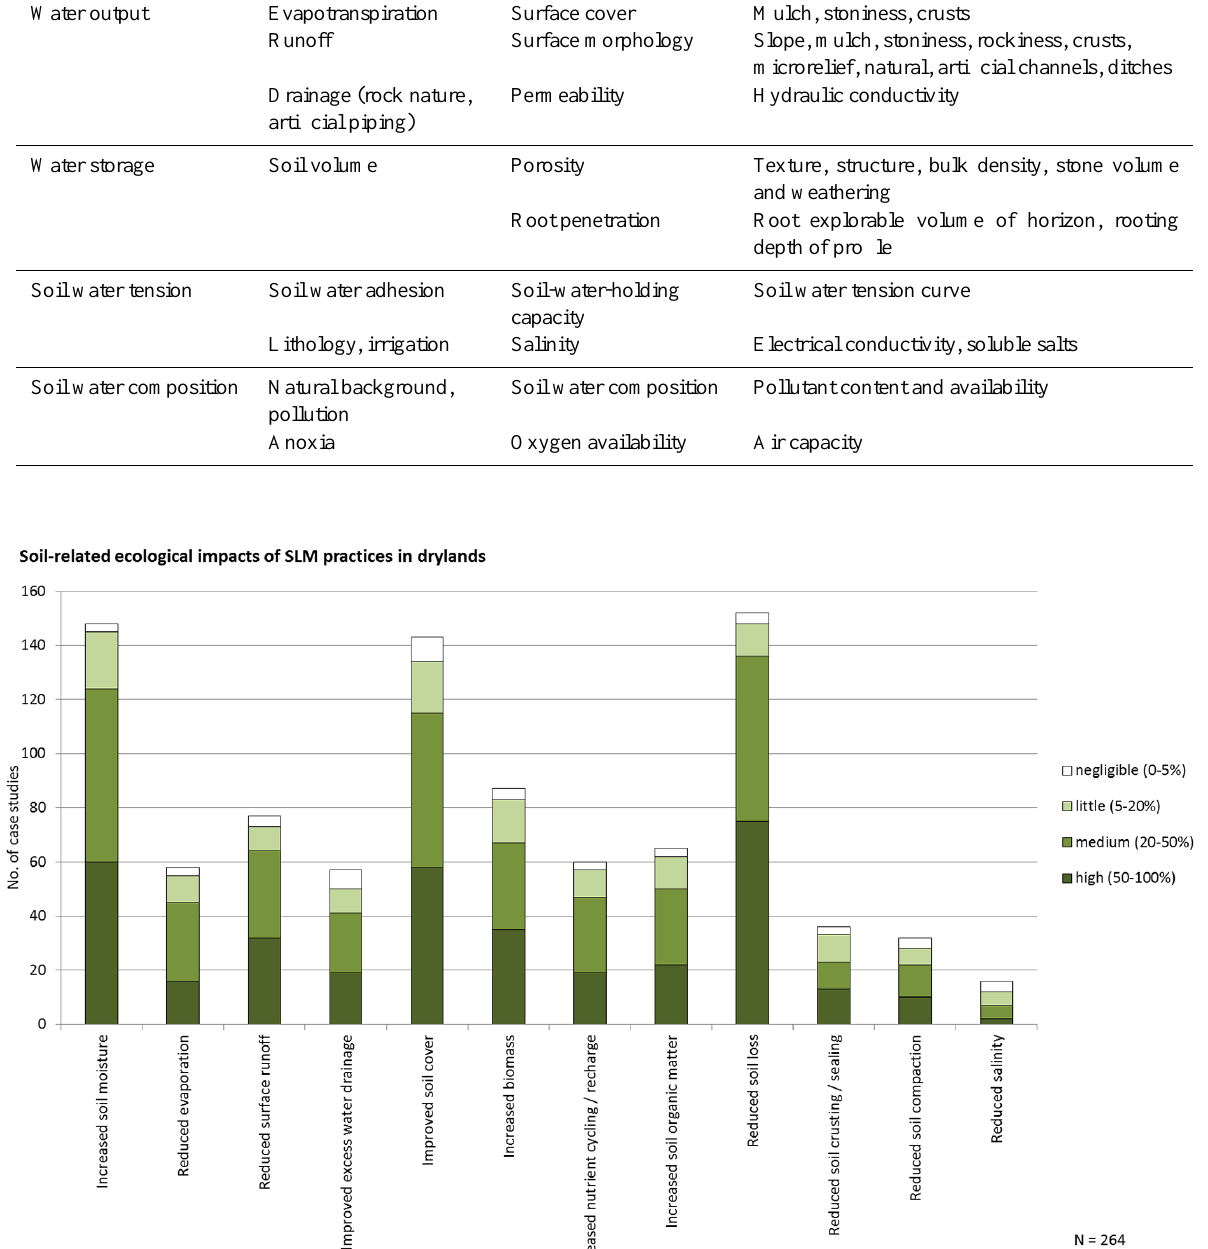
Solid Earth, 7, 397–414,